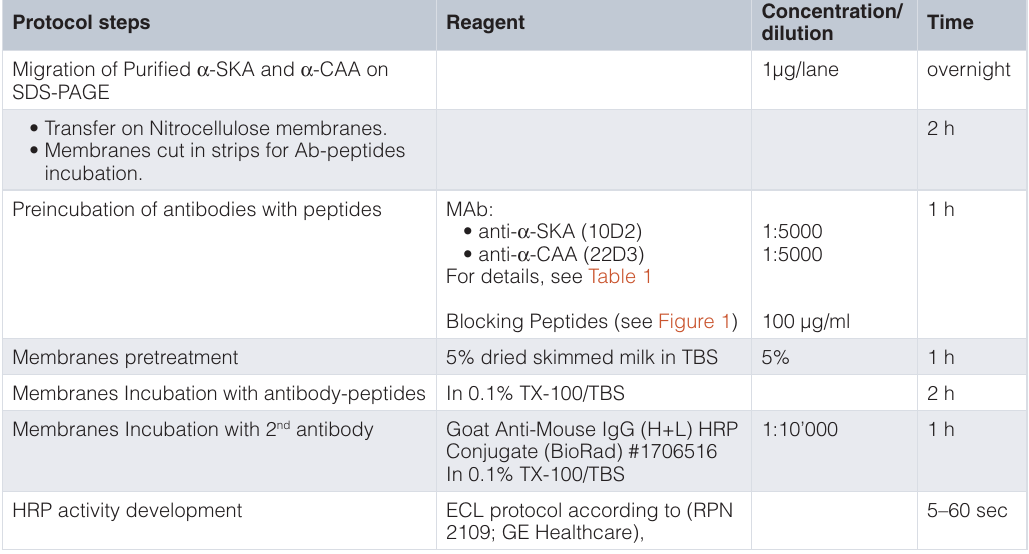
Table 2. Western blot protocol for the identification of the epitopes recognized by anti- α -SKA (clone 10D2) and anti- α -CAA (clone 22D3). Protocol